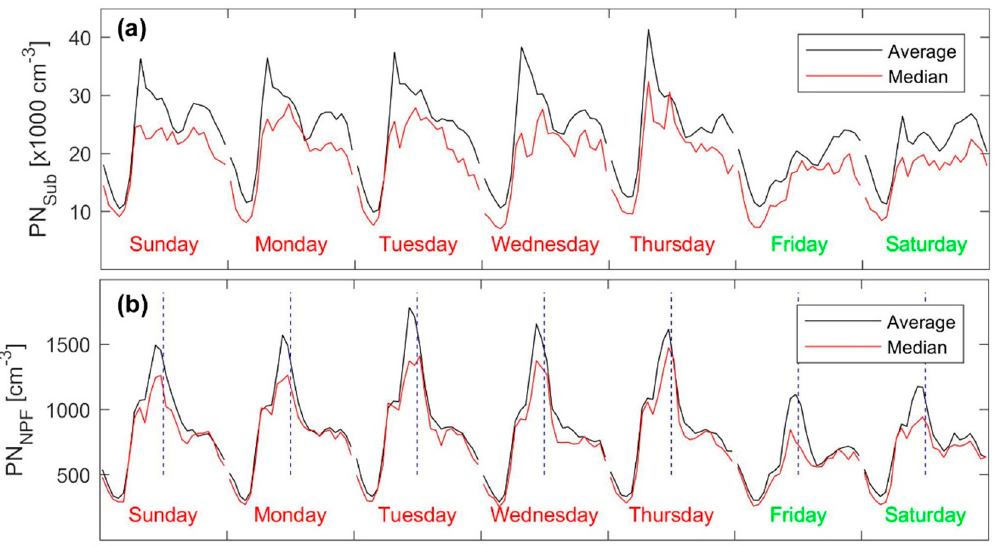
Figure 2. Overall diurnal pattern and weekly cycle of the ( a ) total submicron particle number concentration (PN Sub ) and ( b ) number concentration in the first channel (diameter 10–15 nm); the vertical dashed lines are aligned at noon time.